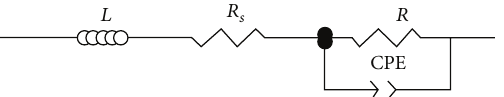
Figure 6: Equivalent circuit used for fitting the impedance data.